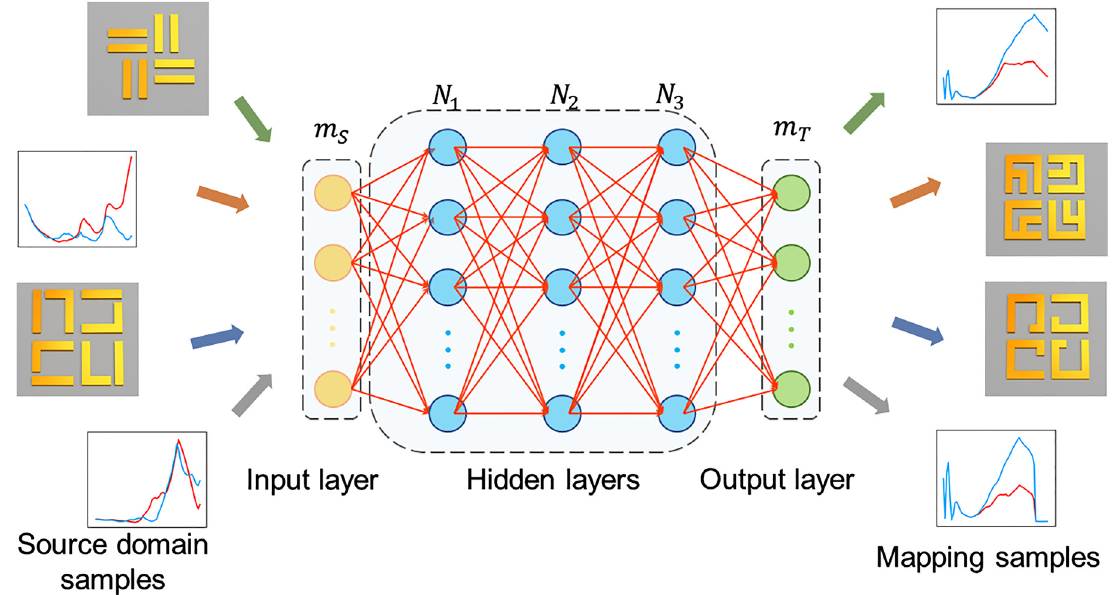
Figure 3: The architecture of the domain adaptive neural network. Theyellow,green,andbluecirclesstandfortheneuronsattheinputlayer,outputlayer,andhiddenlayers,respectively.Thearrowsontheleft and right indicate data flow at the input and output,